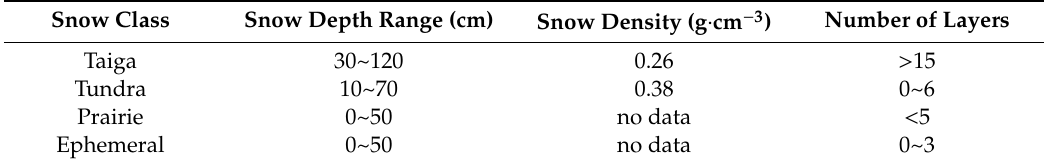
Table 2. Description of snow cover characteristics in di ff erent seasonal snow class.